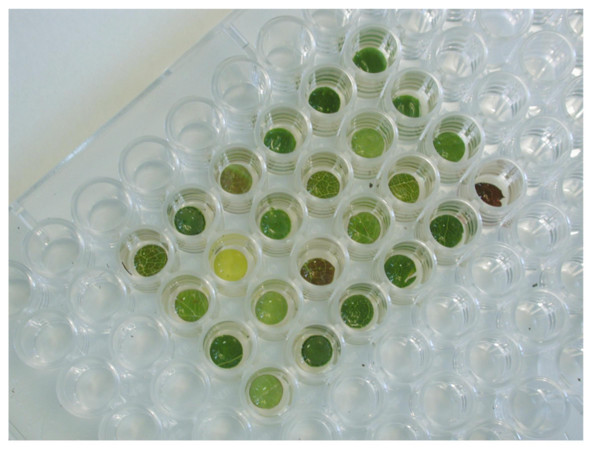
Enzymatic disruption of leaf disks in a microtitration plate. A flat bottom microtitration plate filled with 50 μl of digestion buffer and leaf disks of different species before the adding of the enzymatic cocktail.